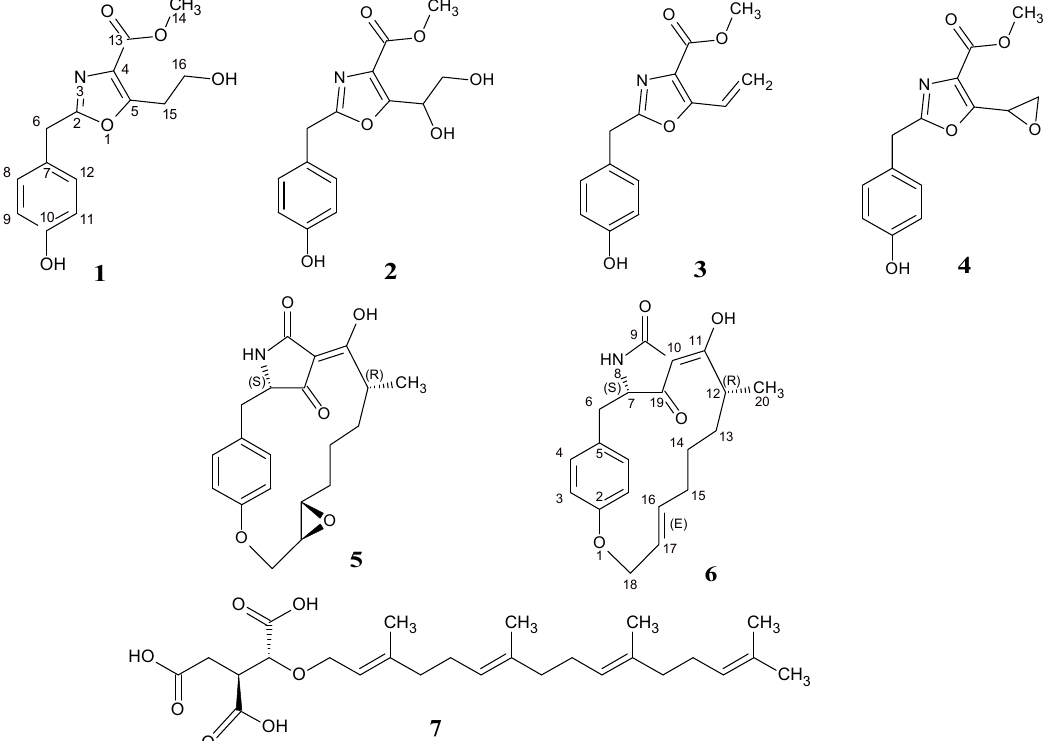
Figure 2. Chemical structures of secondary metabolites isolated from Phoma macrostoma ( 1 – 6 ) and the known biofilm inhibitor microporenic acid A ( 7 ).